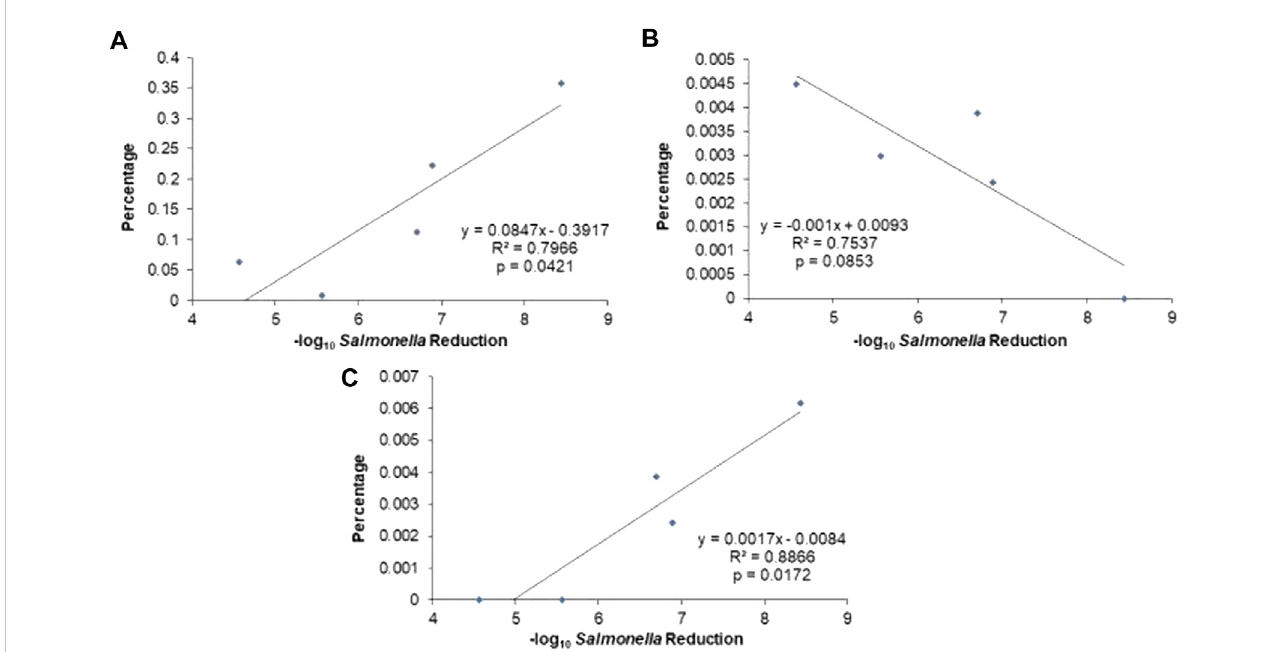
Linear correlation between genus abundance and − log10 reduction in Salmonella by competitive exclusion seeds B, C, D, E, and I. (A) Unclassi fi ed Erysipelotrichaceae 1 . (B) Unclassi fi ed Actinobacteria 2 . (C) Peptococcus . Salmonella reduction data was provided by the manufacturer for seeds and commercial